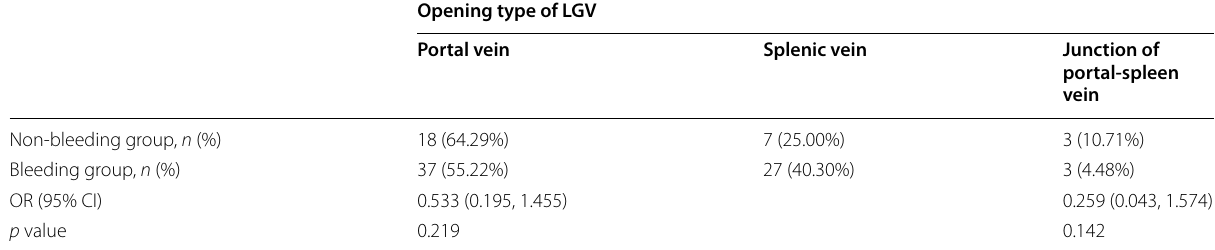
OR: odds ratio, CI: confidence interval